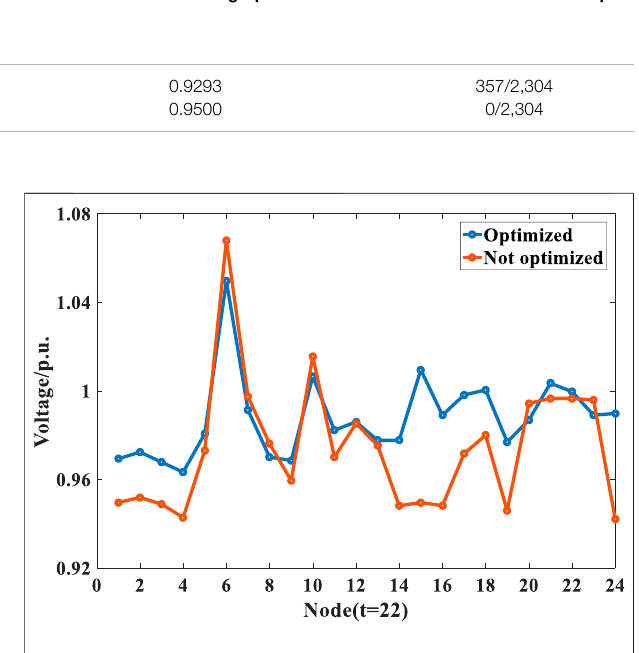
FIGURE 13 | The voltage profile (p.u.) of the network with the random or optimized ESS placement at off-peak time (time step 22).